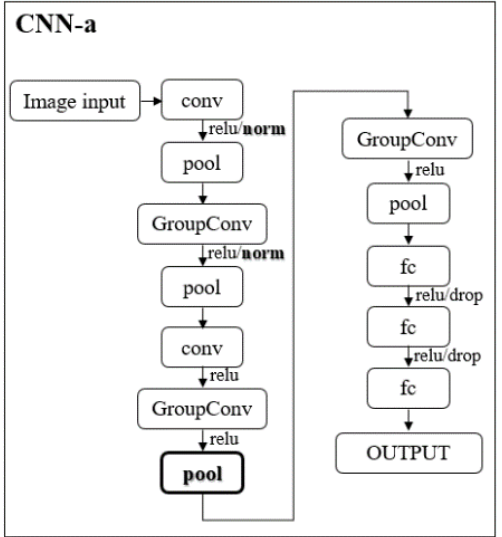
Figure 2. Illustration of CNN-a that resulted from the modifications made (bold) to the AlexNet architecture. Conv and GroupConv: convolutional and grouped convolutional layers, respectively; pool: max pooling layers; fc: fully connected layer; relu: rectified linear unit layer; norm: batch normalization layer; drop: dropout layer.